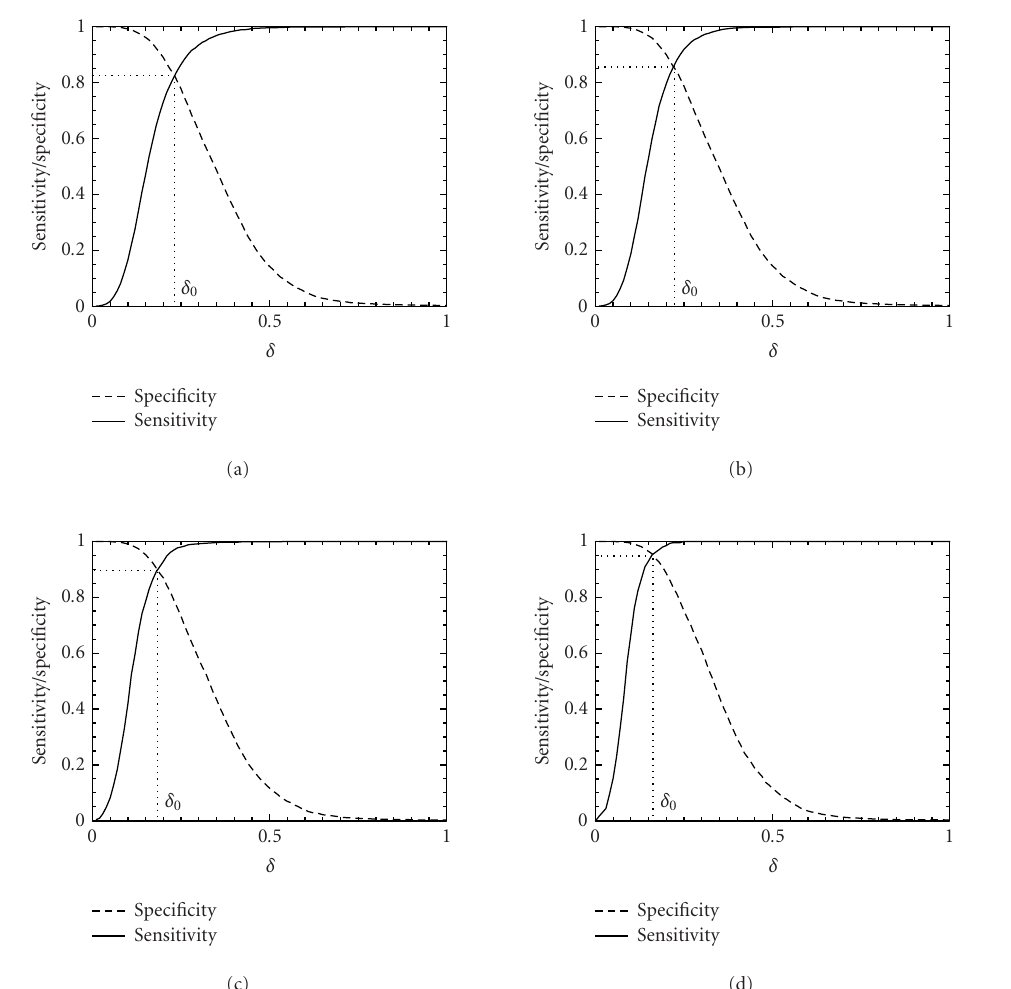
Figure 4. Distributions of MAXFD for the coding (solid curves) and noncoding (dashed curves) subsets of the 16 yeast chromosomes. The sliding window size is w = 512. The parameters n 1 and n 2 designate the coding/noncoding segments with lengths greater than n 1 and n 2 , respectively. (a) n 1 = n 2 = 1, (b) n 1 = n 2 = 256, (c) n 1 = n 2 = 512, (d) n 1 = n 2 = 1026. See the text and Table 1 for more